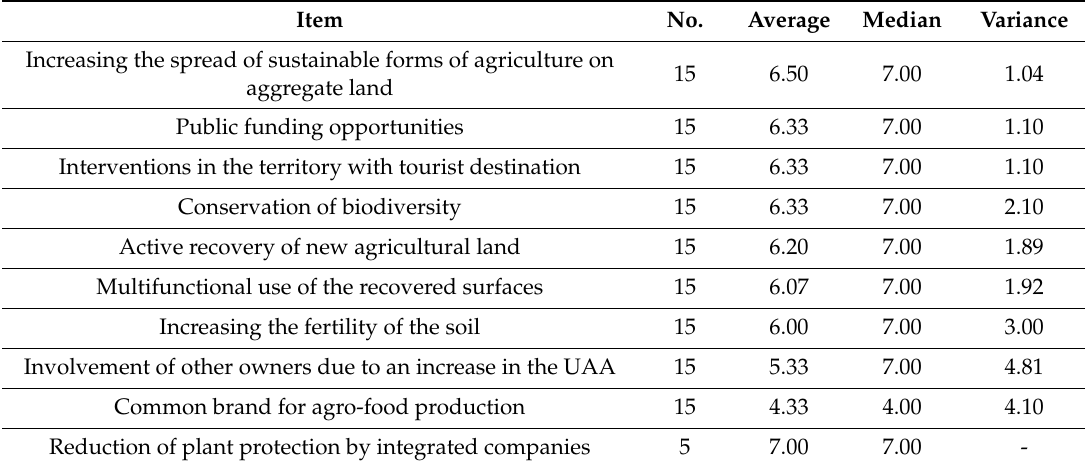
Table 4. Evaluation of the opportunities generated by the land consolidation associations.